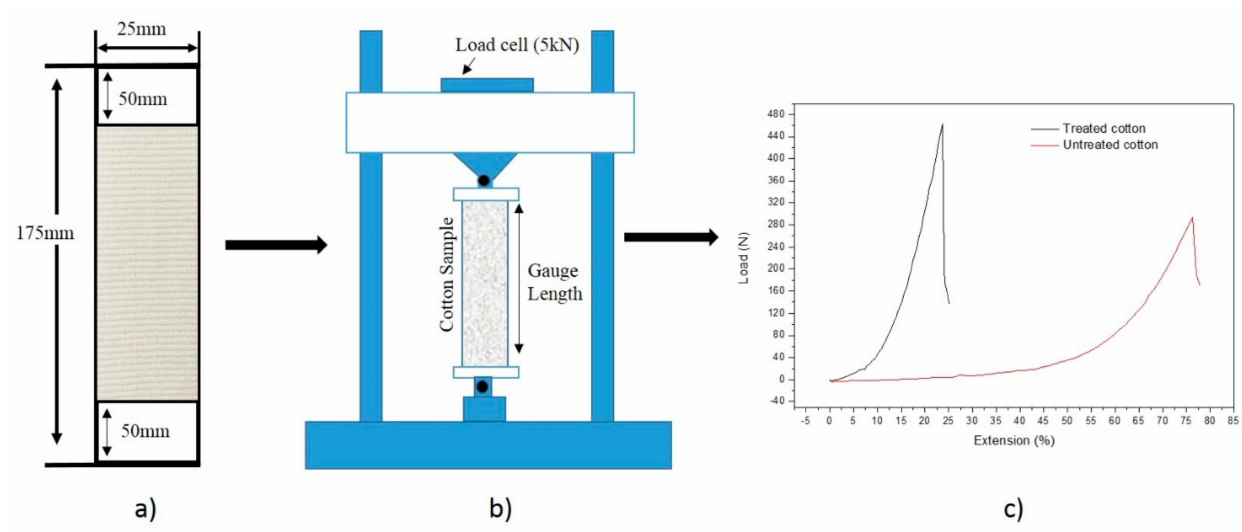
Figure 7. Tensile strength test: ( a ) Cotton sample dimensions, ( b ) The Apparatus for tensile test and ( c ) Load-extension curves of control and treated cotton